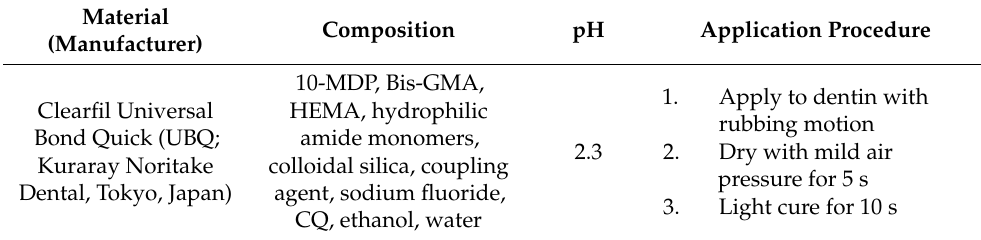
Table 2. Composition and application procedure of materials used in this